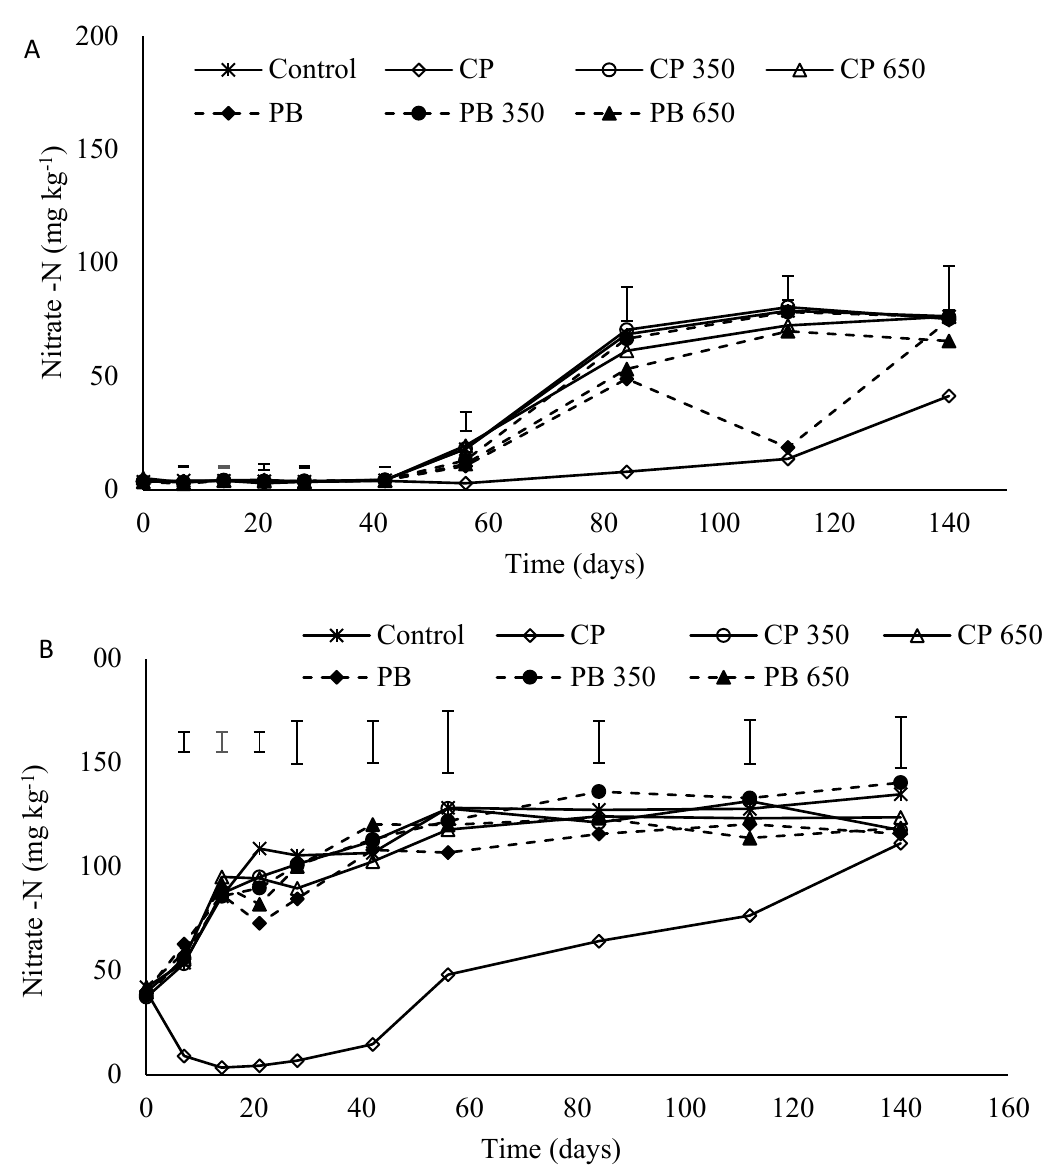
Figure 6. Concentrations of nitrate − N during incubation of Luvisol ( A ) and Ferralsol ( B ) amended with biochar from cull potato (CP) and pine bark (PB) produced at varying pyrolysis temperatures. CP = cull potato; PB = pine bark; CP 350 = cull potato biochar at 350 °C; CP 650 = cull potato biochar at 650 °C; PB 350 = pine bark biochar at 350 °C; PB 650 = pine bark biochar at 650 °C. The vertical error indicates LSD ( p < 0.05).